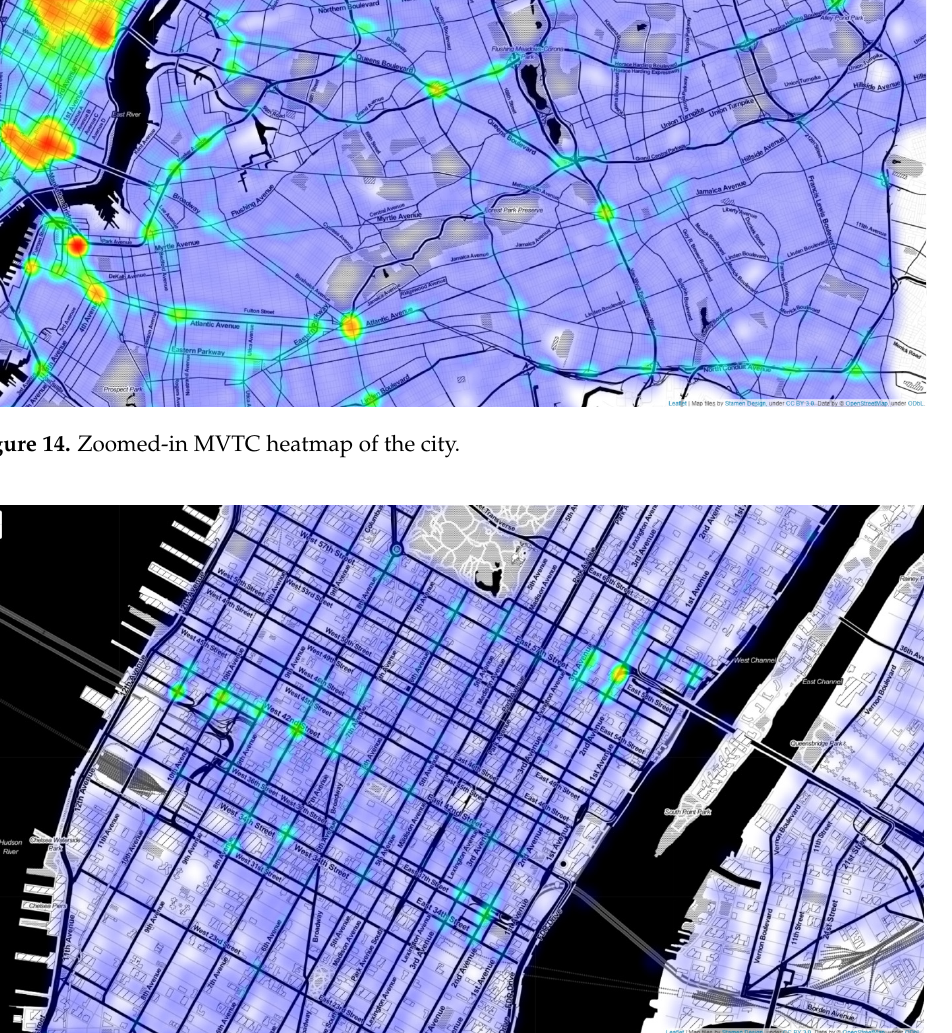
Figure 15. Zoomed-in heatmap of traffic collisions in the western part of the city.